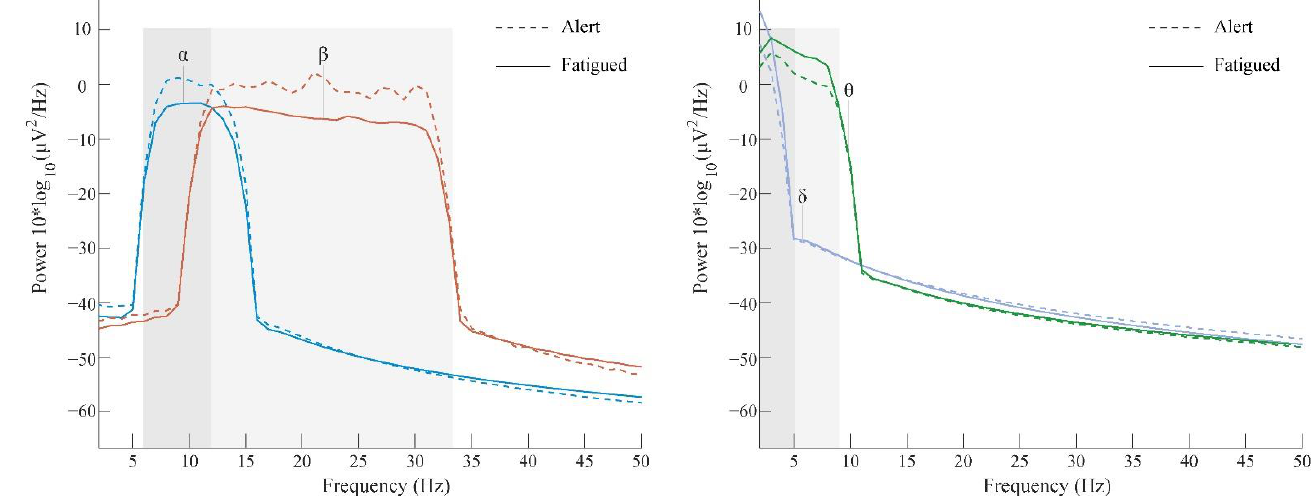
Figure 5. Power spectra of θ , α , δ , and β rhythms before and after fatigue-inducing tasks.